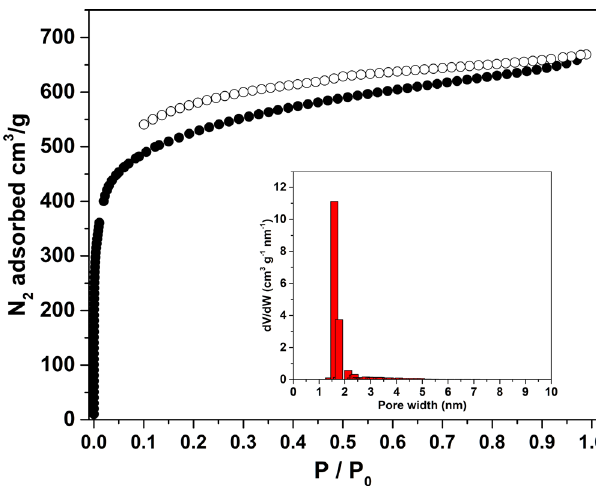
Fig. 2 Porosity measurements. N 2 gas sorption isotherm at 77 K for CPOC- 301, inset: the calculated PSD